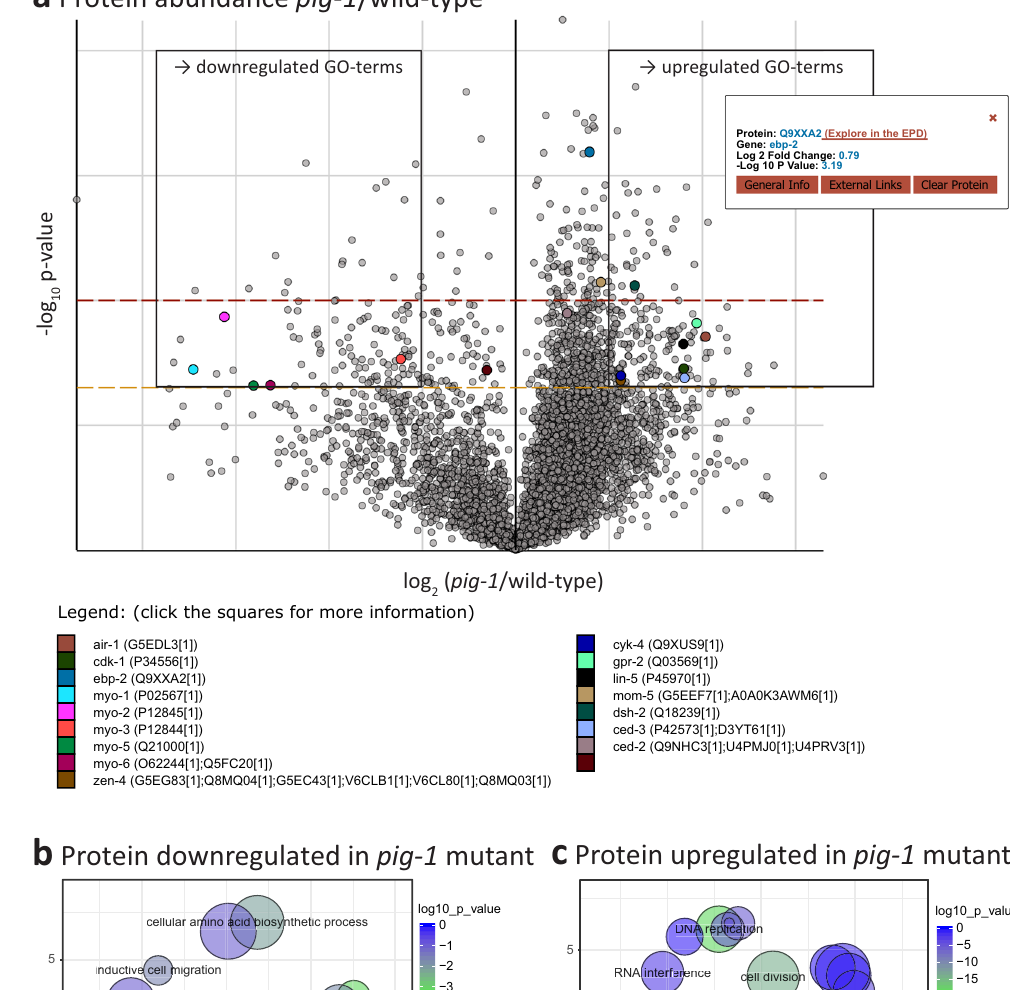
c Protein upregulated in pig-1 mutant b Protein downregulated in pig-1 mutant